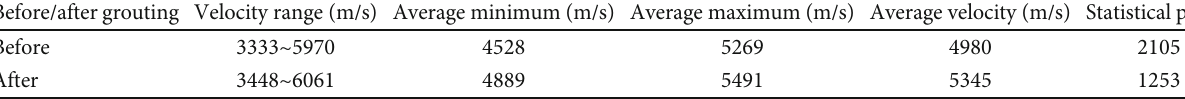
Table 8: Variation in wave velocity before and after grouting.